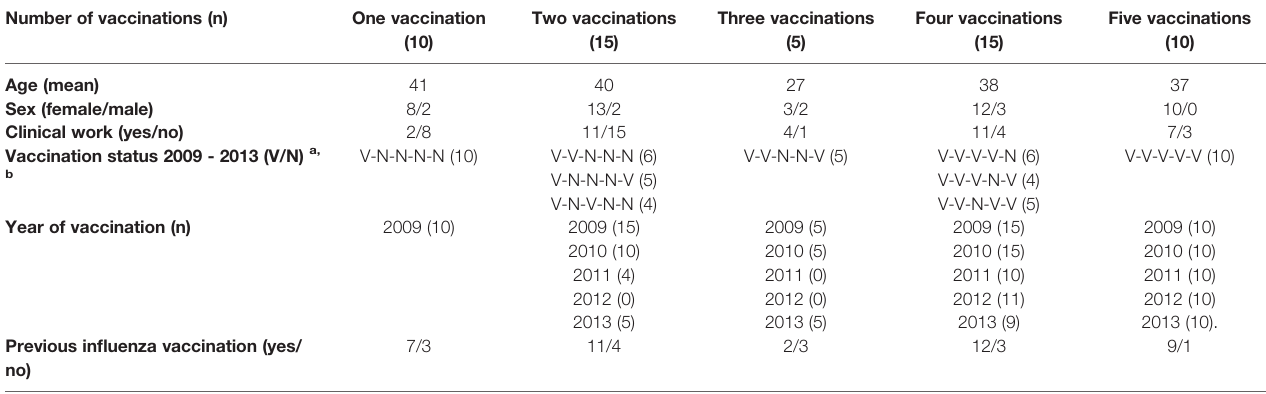
TABLE 1 | Demographics and vaccination histories of the healthcare workers. Number of vaccinations (n) One vaccination